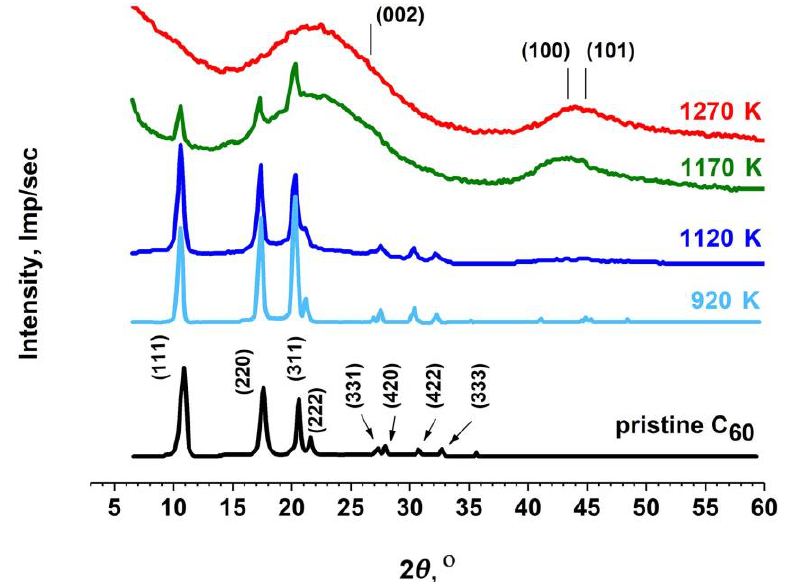
Figure 2. XRD patterns of the pristine and HIP-treated at different temperatures fullerite C 60 . The vertical lines at the top indicate the HOPG diffraction peaks (002), (100) and (101).